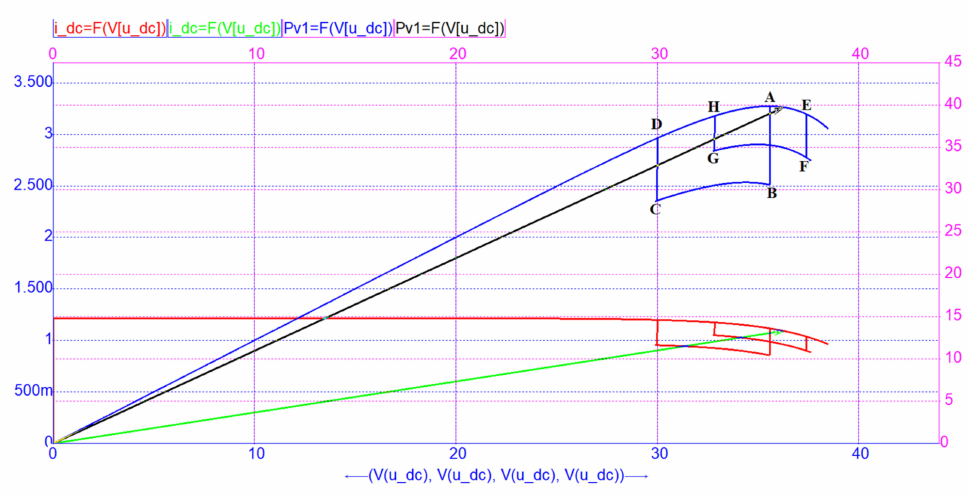
Figure 26. Simulation of the OP movement on the I-V and P-V PV module characteristics.